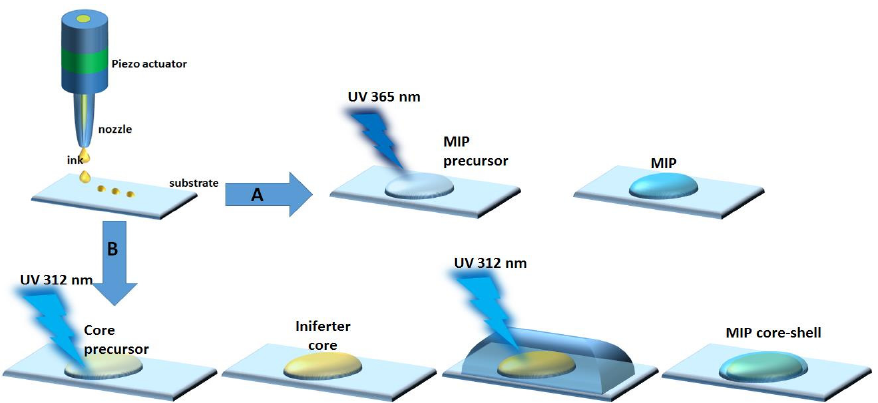
Figure 3. Two concepts of inkjet-printed MIP arrays. ( A ) direct patterning of MIP formulation; ( B ) Core–shell approach: a core made of TRIM is patterned and polymerized with the iniferter BDC. A shell made of MIP is grafted in a second step by reinitiating the polymerization.